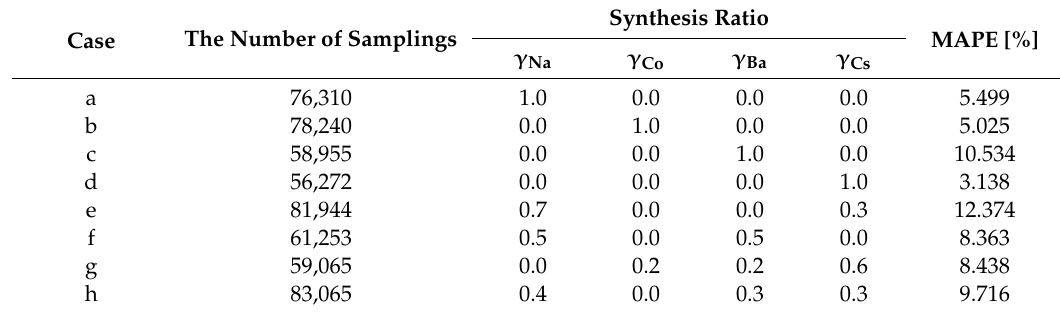
Figure 7. Results of Compton edge reconstruction for seven cases in the test set. Each synthesis ratio is presented in Table 1. Table 1. Information on seven cases in test set and their corresponding mean absolute percentage error (MAPE) values.